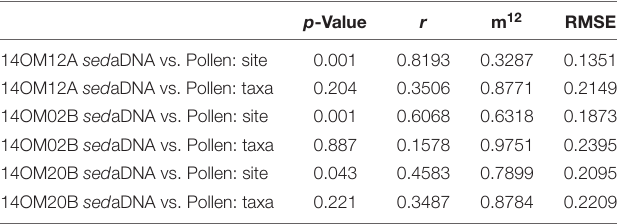
TABLE 3 | Results of Procrustes and PROTEST analyses indicating the insignificant similarity of taxa but significant similarity of samples between sed aDNA data and pollen data.